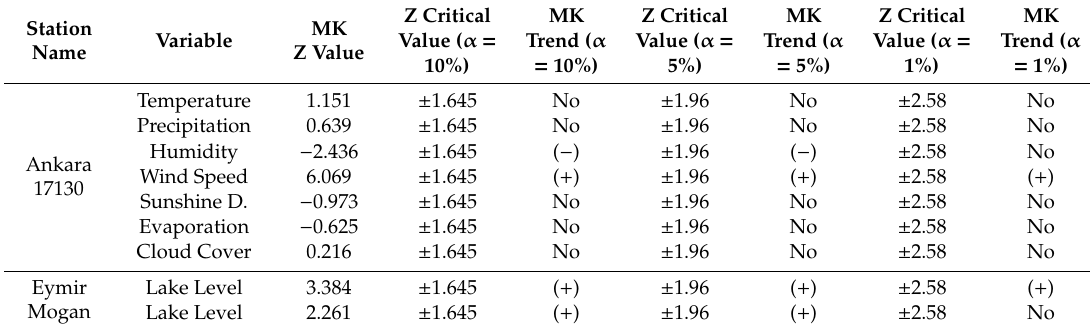
Table 3. Results of the MK method.